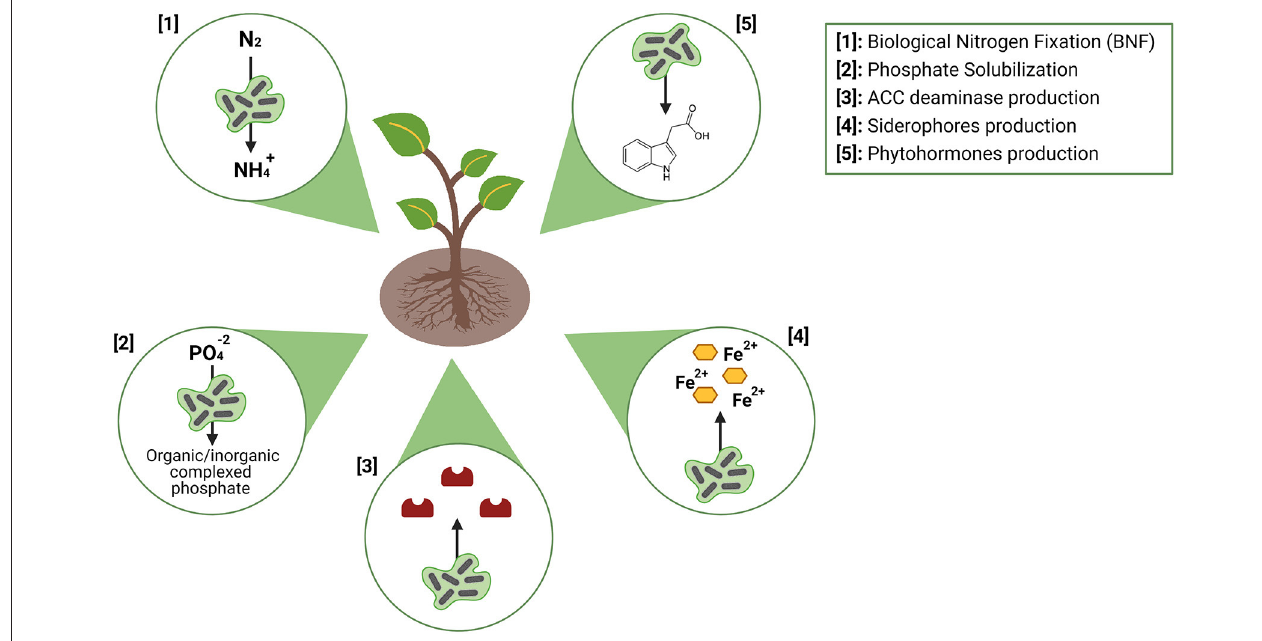
FIGURE 3 | Main mechanisms of action of plant-growth promoting bacteria (PGPB; Figure by authors). Created with